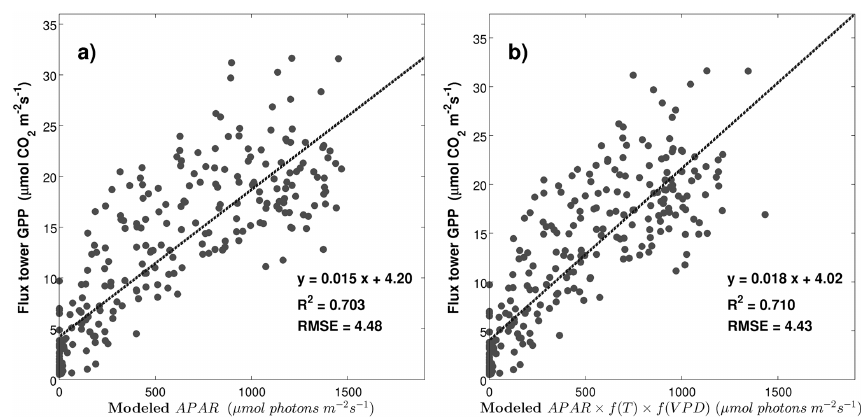
Figure 12. Regressions between modeled APAR and measured GPP. Half-hourly data are shown from DOY 217 to 224 in 2004 for US-Bar. The influences of temperature and vapor pressure deficit are modeled based on Equations (51) and (52). Only data during the photosyntheti- cally active period are included in the regression. The dashed lines denote the regression lines.